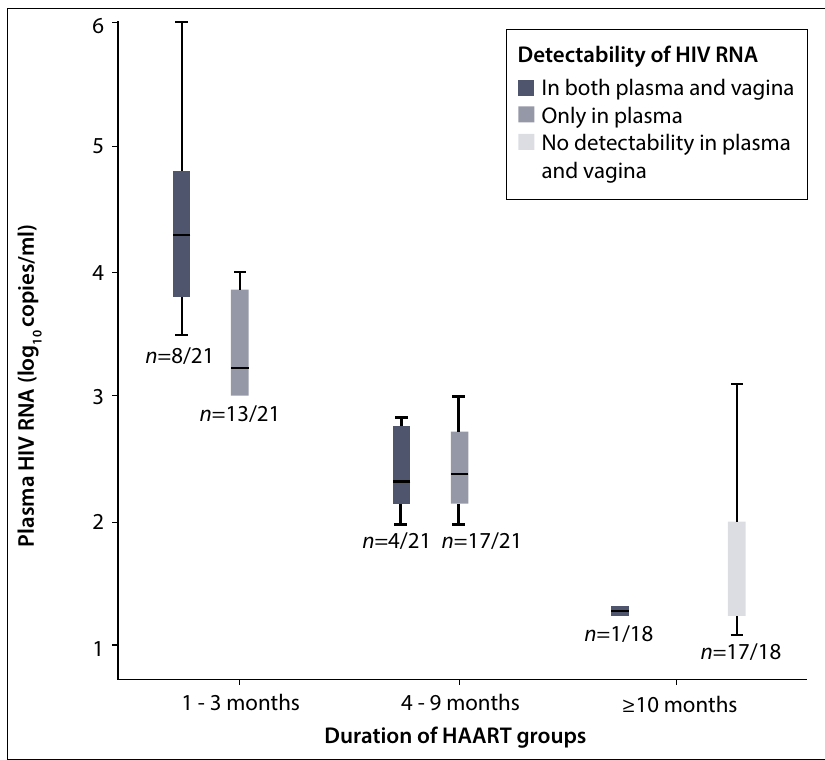
Fig. 1. Distribution of plasma HIV loads and genital HIV RNA detectability among HAART recipients ( n= 60). (HAART = highly active antiretroviral Table 1. HIV RNA levels in plasma and GT by HAART duration ( N =60) HAART duration (months)